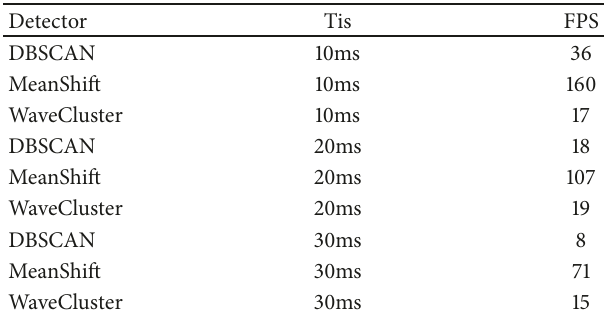
Table 7: The FPS for EventSeq-Vehicle1 using different detection methods (DBSCAN, MeanShift, and WaveCluster). The impact of time intervals from 10ms to 30ms was studied.